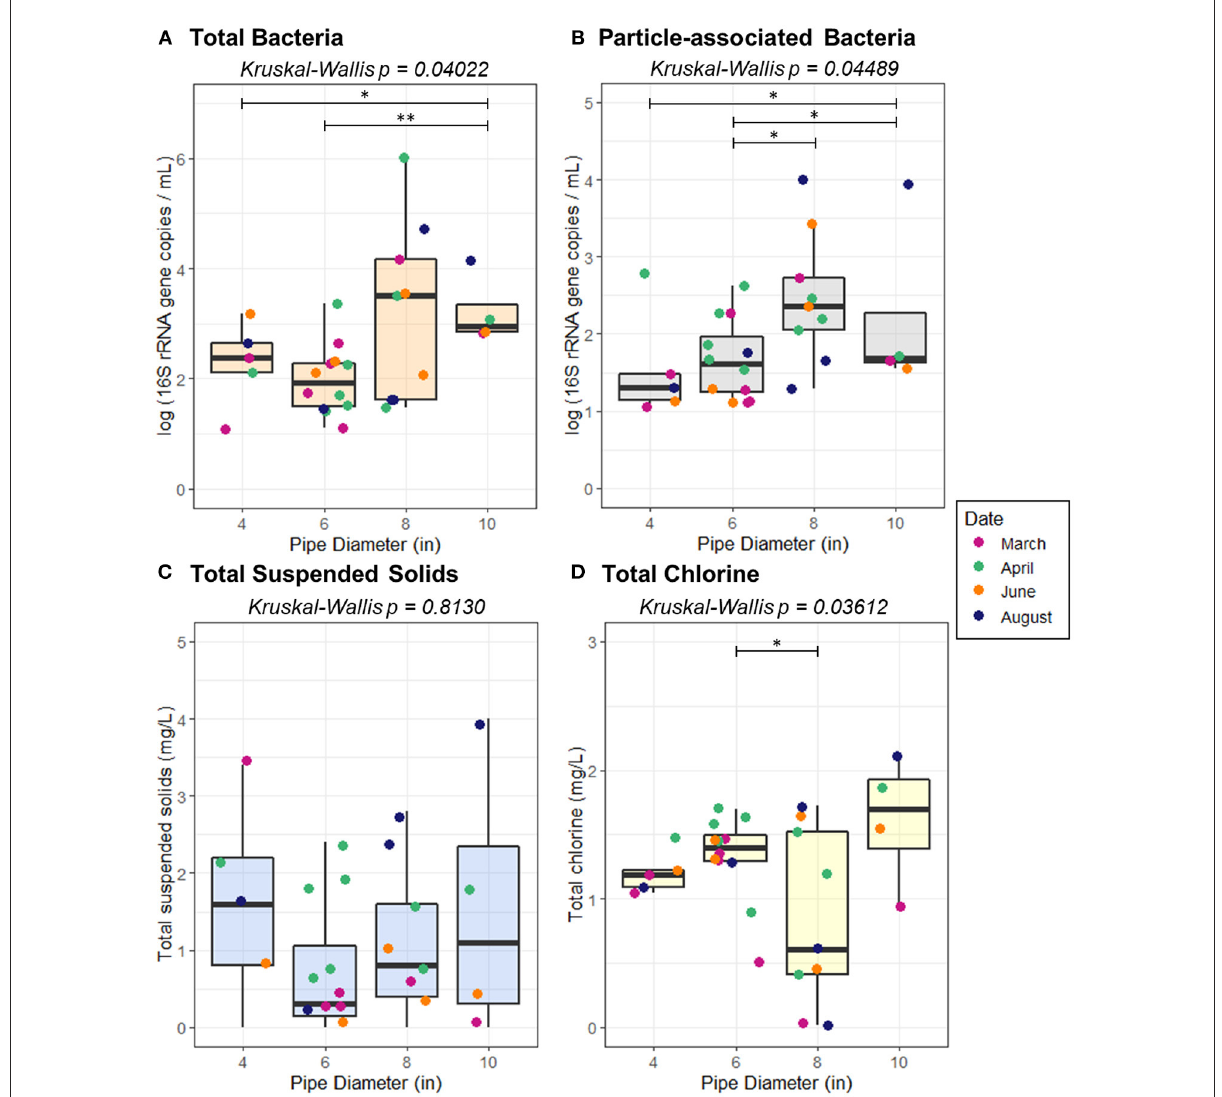
FIGURE5 Abundance of (A) total bacteria (B) particle-associated bacteria, (C) total suspended solids, and (D) total chlorine as a function of pipe diameter. Pairwise statistical significance was assessed using a Wilcoxon Rank Sum Test; * p < 0.05, ** p <